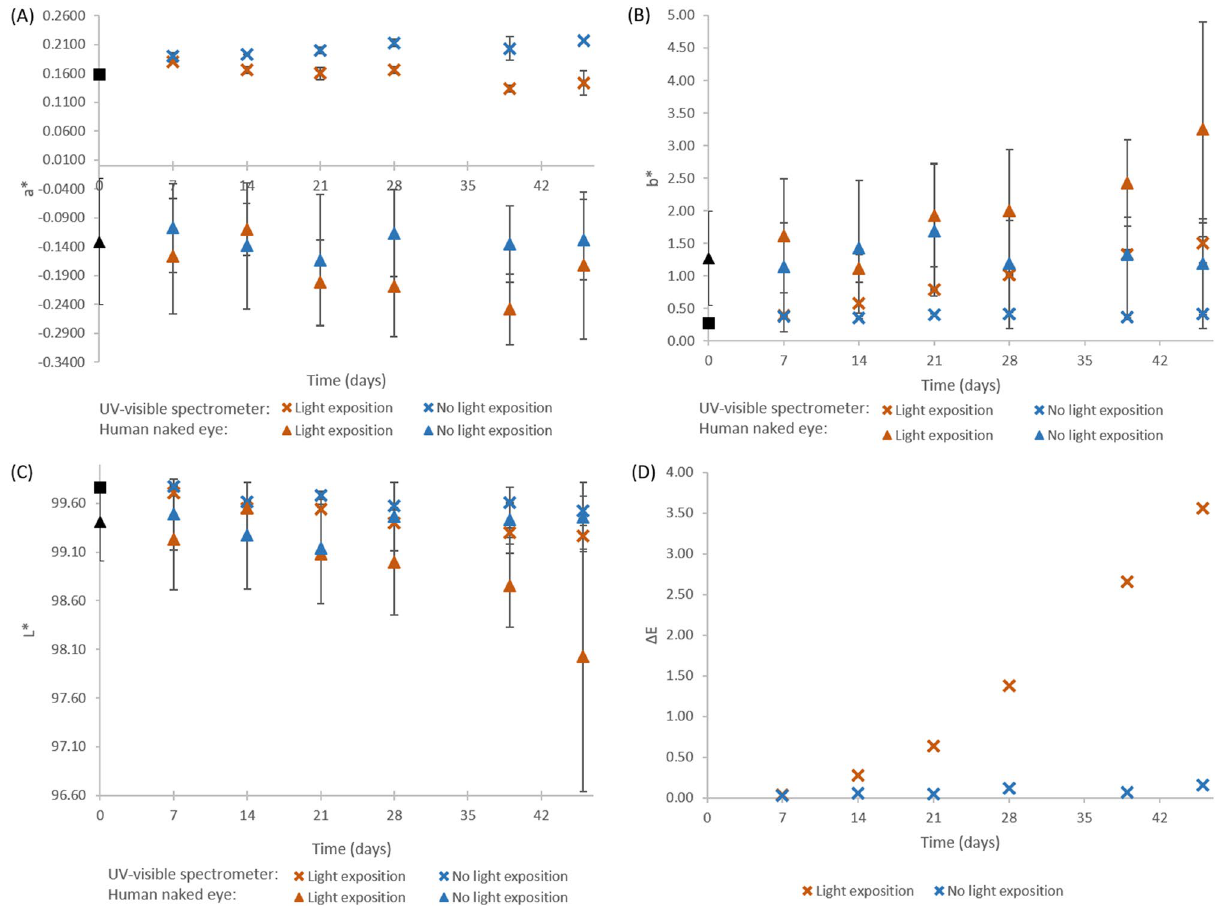
Figure 3. Colors parameters of paracetamol solution observed by UV–Vis spectrometer or visual examination according to time and light exposition conditions: ( A ) a*, ( B ) b*, ( C ) L* and ( D ) ∆E (only for the spectrophotometric analysis). Results expressed as mean ± standard deviation, n = 3, except for ( D ) (difference of means, n = 1). Crosses: spectrophotometric data; triangles: human naked eye (visual examination) (p-values of 0.838, 0.598 and 0.578 for respectively a*, b* and L* after 46 days of storage). When the samples were exposed to light radiations, the difference still wasn’t significant after 28 days for a* (p = 0.054), but it became so after 39 days (p = 0.002). b* differences were however slightly significant for the visual examination from day 28 onward (p = 0.002), but a change in L* vales was only detected as significant after 39 days (p = 0.015). ΔE values varied from 0.027 to 0.163 for the samples stored in the dark (days 7 to 46) and from 0.035 to 3.558 (days 7 to 46) when exposed to light. In that condition, ΔE values were of 1.381 and 2.653 at days 28 and 39, respectively. As for the study of the parenteral nutrition solutions, the visual examination results are more variable than the measurements made by the spectrophotometer. Parenteral nutrition solution. Figure 4 represents the evolution of each chromaticity parameters (a*, b* and L*) and difference of perception (ΔE) calculated by Eq. (4). Complete data is presented in Supplemen- tary data file S1. Chromaticity measurements at day 0 were of a* and b* of − 0.045 ± 0.008 and 0.310 ± 0.093, respectively (mean ± standard deviation), thus confirming the slight yellow color detected by the visual exami- nation. Overall, throughout the study and for both storage conditions, a* and L* values decreased and b* values increased, corresponding to a shift toward browner and darker solutions. The spectrophotometer detected a change of chromaticity components a* and b* for both storage conditions (5 °C and 25 °C) after only 7 days of storage (p < 0.0015), but a change of lightness was only detected after 21 days when the PSN solutions were stored at 5 °C. Comparatively, the visual examination detected a change (chromaticity of lightness) after 14 days (25 °C storage condition, p < 0.001) or 46 days (5 °C storage condition, p < 0.018). ΔE values varied from 2.83 to 86.9 at 25 °C (days 7 to 46) and from 0.41 to 2.02 (days 7 to 46) when stored at 5 °C, with a ΔE value of 1.40 at day 39. Overall, it can also be noticed that the visual examination results are more variable than the measurements made by the spectrophotometer. Sterility test.